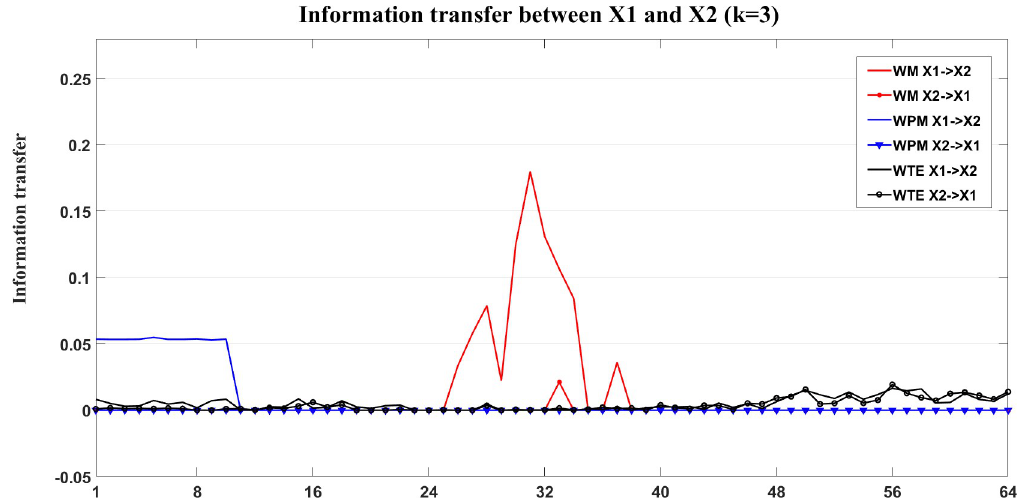
Fig 17. Information transfer between X1 and X2. In this figure, the bias corrected WM (red), WPM (blue) and WTE (black) information transfer between X1 and X2 are plotted at different time scales s (i = 1,2, ... 64). By comparing the strength of i information transfer between X1 and X2, WPM identifies X1- > X2 at small time scales, while WM identifies X1- > X2 at middle time scales. WTE gives similar and small strength on both directions that hard to identify a clear direction for the interaction.